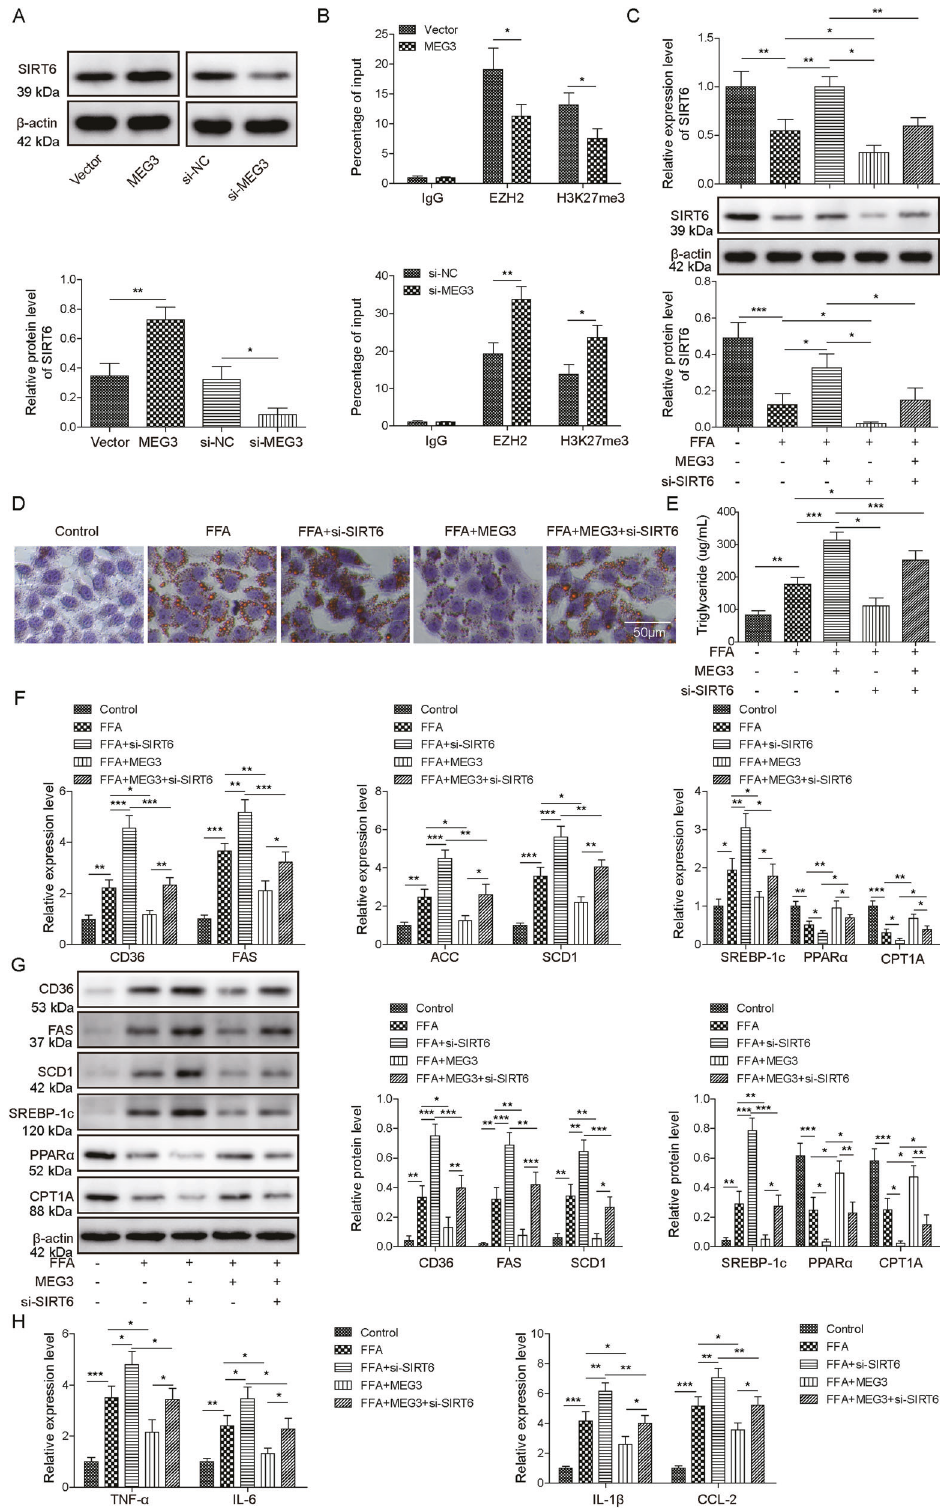
Fig. 4 SIRT6 mediated the protection of MEG3 on FFA-challenged hepatocytes. A The expression of SIRT6 was measured by Western blot in indicated hepatocytes. B Binding of EZH2 and H3K27me3 to the promoter of SIRT6 was detected by ChIP assay. IgG was used as the negative control. C SIRT6 expression in indicated hepatocytes was measured by RT-qPCR (upper panel) and Western blot (lower panel). In indicated hepatocytes, Oil Red O staining ( D ), triglyceride assay ( E ), mRNA ( F ) and protein ( G ) of indicated lipogenesis-related genes, and expressions of pro-in fl ammatory TNF- α , IL-6, IL-1 β , and CCL2 ( H ) were performed. * P < 0.05, ** P < 0.01 , *** P < 0.001.